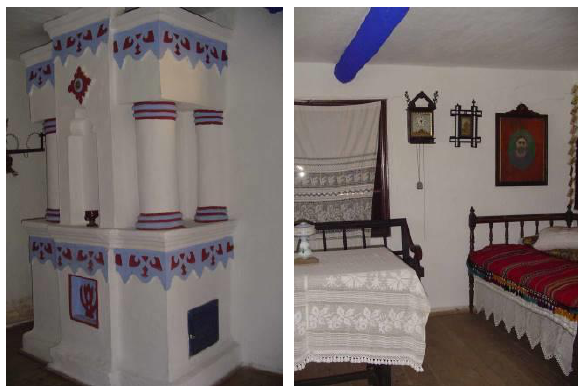
Figure 8. Interior of the 17th Century Jurilovca house. Village